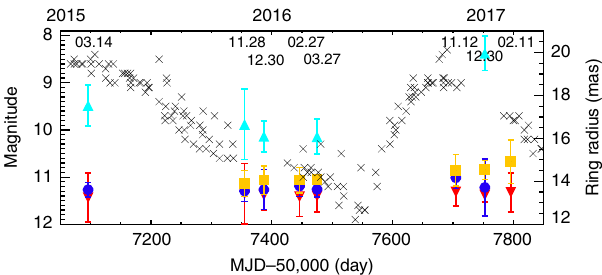
Fig. 4 Variation of the SiO ring radius with the optical light curve (in press manuscript 14 ). The gray cross indicates the optical light curve from American Association of Variable Star Observers (AAVSO; https://www.aavso.org). Color symbols indicate the SiO maser ring radius according to the different transitions and epochs. Cyan triangle, yellow square, blue circle, and red inverted triangle are in the order of 129.3, 86.2, 43.1, and 42.8 GHz SiO maser lines (Table 1,